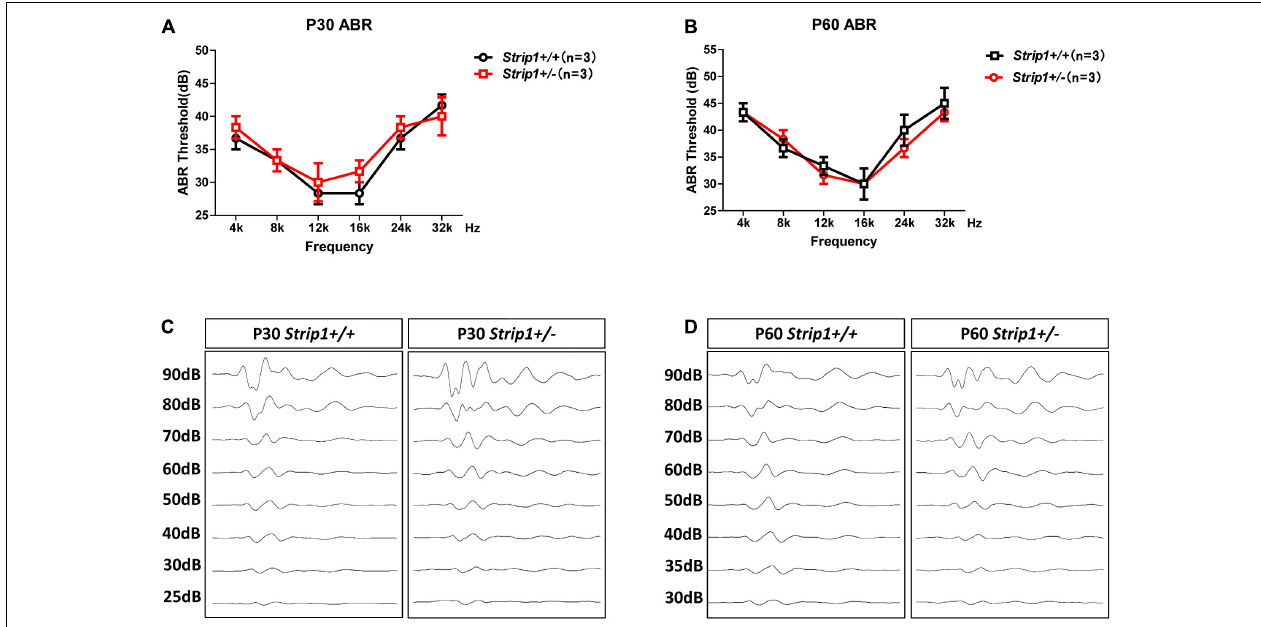
FIGURE 4 | ABR tests of P30 and P60 mice. (A,B) The hearing function of P30 (A) and P60 (B) Strip + / − mice and Strip1 +/+ mice was tested by ABR. n refers to the number of mice. (C,D) The ABR waveform at 16 kHz in P30 (C) and P60 (D) Strip + / − mice and Strip1 +/+ mice.